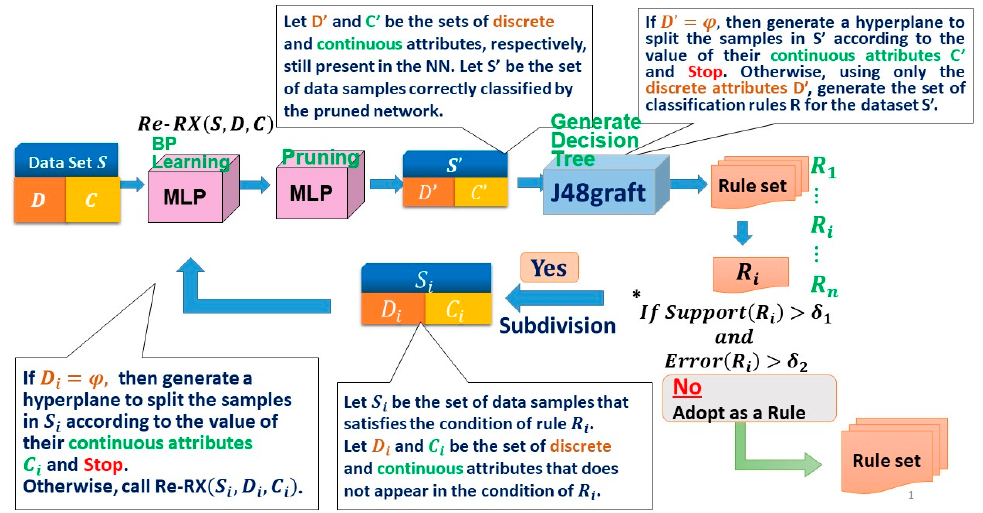
Figure 2. The Recursive-Rule Extraction (Re-RX) with J48graft algorithm.